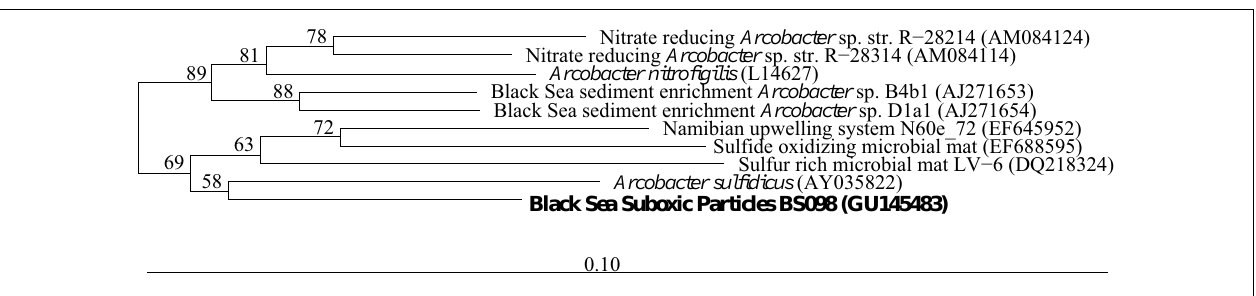
FIGURE 9 |A bootstrapped (1000) neighbor joining phylogenetic tree of relevant members of the Arcobacter genus was created in arb after aligning to a master database using NAST (greengenes.lbl.gov). The Arcobacter sequence from the Black Sea suboxic zone is in bold.